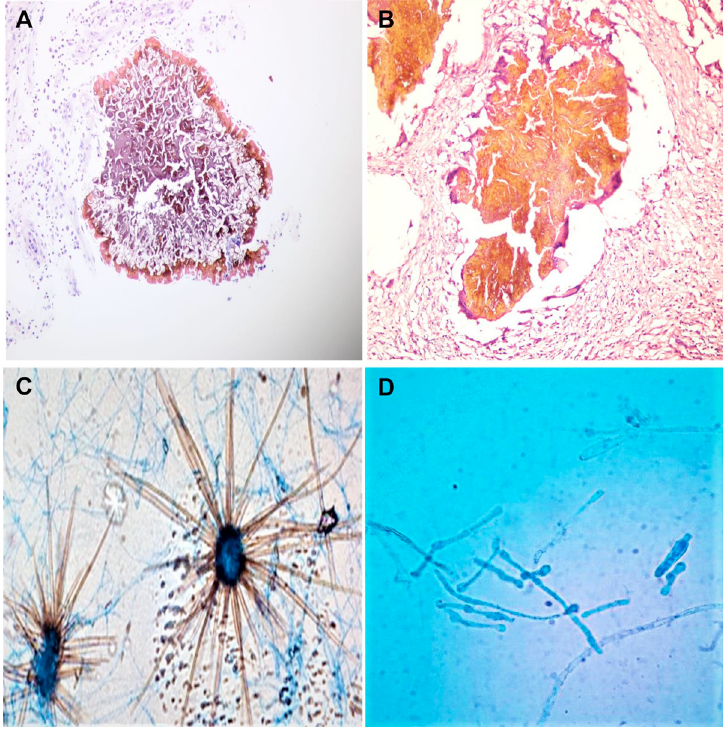
Fig 2. Microphotograph showing multiple black grains surrounded by granulation tissue with marked histiocytic and mixed inflammatory cellular infiltrates (HE 10 × ). (A) Grains of Chaetomium spp. showed abundant extracellular matrix, which was yellow to brown in colour, and the fungus hyphae are located at the periphery of the matrix with short filamentous structure. (B) The filamentous pattern of M . mycetomatis grains consists of brown septate and branched hyphae at the centre and periphery with long filament. (C, D) Microphotograph of LPCB mount showing ascoma and ascospore cells resembling the typical Chaetomium spp. cells (C) and conidia of M .